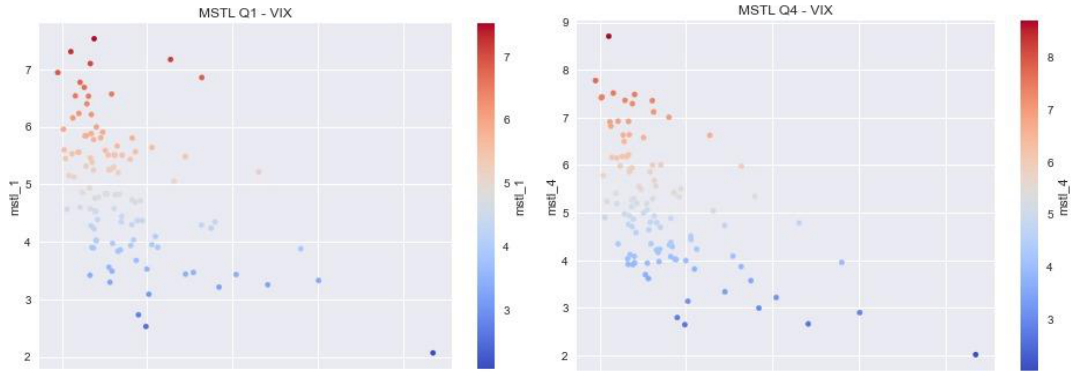
Figure 3. MSTL Q1 – MSTL Q4 and VIX. This figure shows the relationship between the VIX and the MSTL-Q1 and MSTL-Q4 for the full period under analysis. Source: authors ’ elaboration.